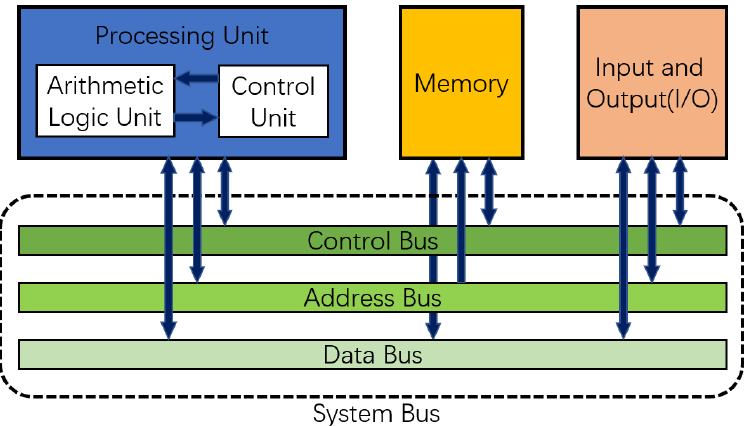
Figure 2. Architecture of Von Neumann computing